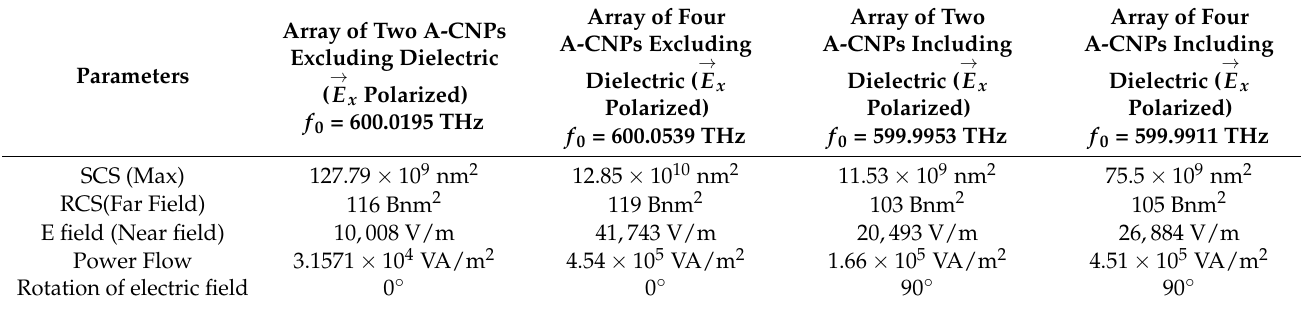
Table 2. Comparison of optical properties for the two models (I and II) with the two configurations (I and II).